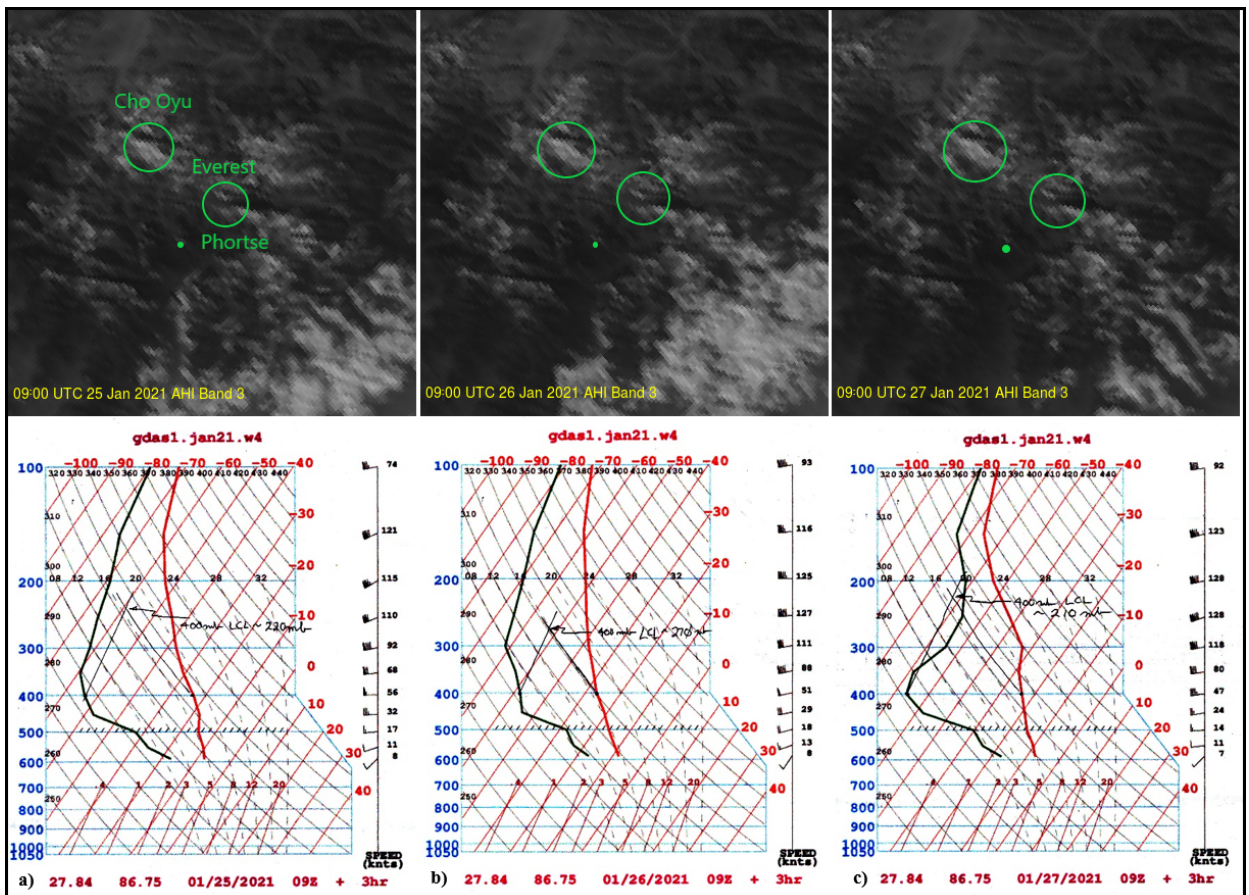
Figure 4. The images and profiles (a) , (b) , and (c) are for 25, 26, and 27 January 2021, at 15:00 LST or 09:00 UTC. The major peaks are circled and the location of Phortse is labeled. The lifting condensation level (LCL) values are determined graphically on the corresponding atmospheric profiles from Phortse and are listed in Table 1. The graphical procedures are described in the text. The pressures at the base and summit of the Everest pyramid, respectively, are approximately 400 and